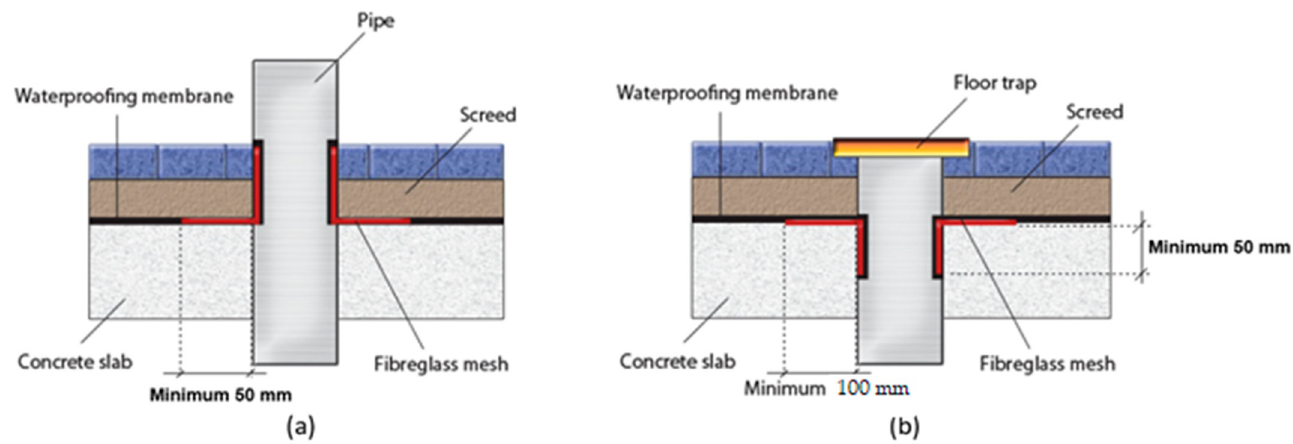
Figure 2. Case building selection and sampling.